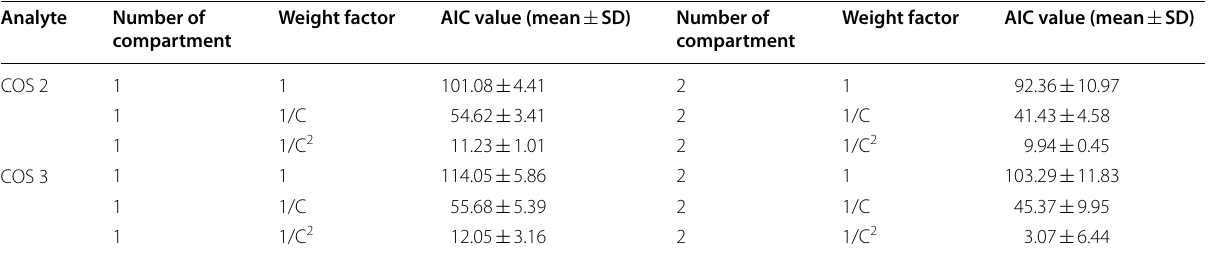
Table 7 Akaike information criterion (AIC) values of compartment model of rats with intravenous administration of COS 2 and COS 3 Analyte